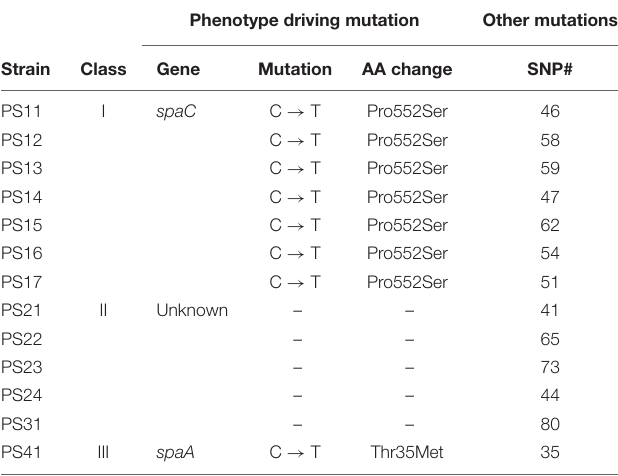
SNP#: Quantity of other single nucleotide mutations in the